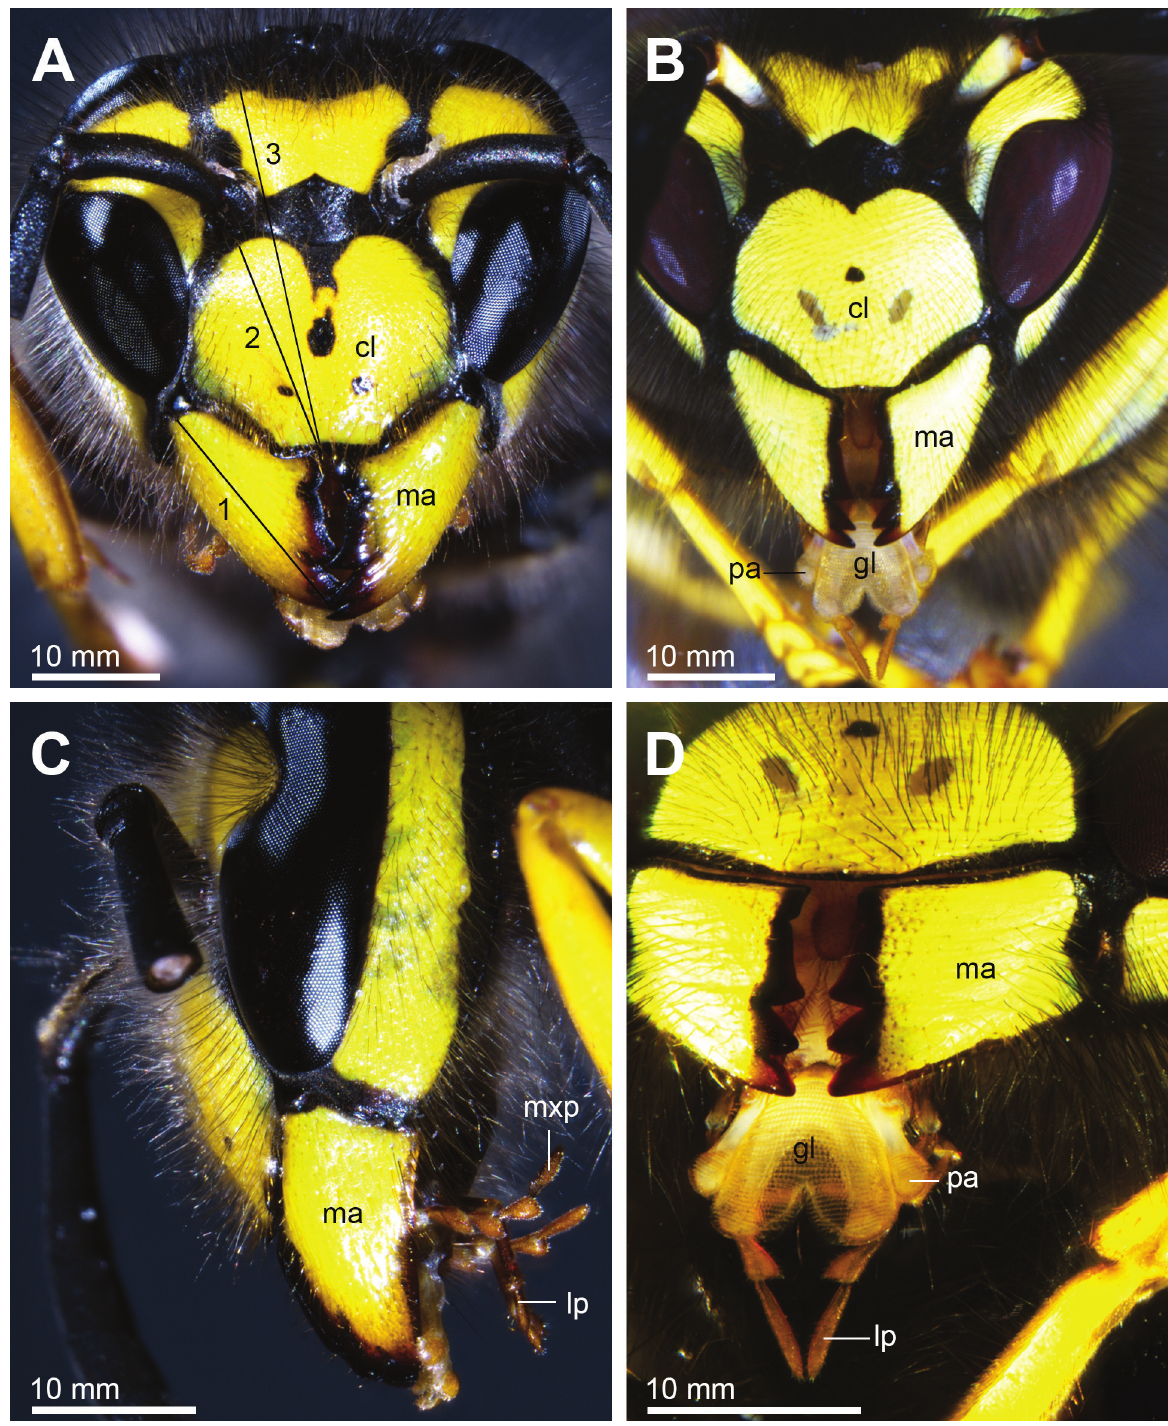
Figure 1. Head of Vespula germanica (LM). A. Female worker in frontal view; 1, 2, 3 measuments taken to compare head size. B. Male in frontal view. C. Female worker in lateral view. D. Male in ventral view; cl – clypeus, gl – glossa, lp – labial palpus, ma – mandible, mxp – maxillary palpus, pa –